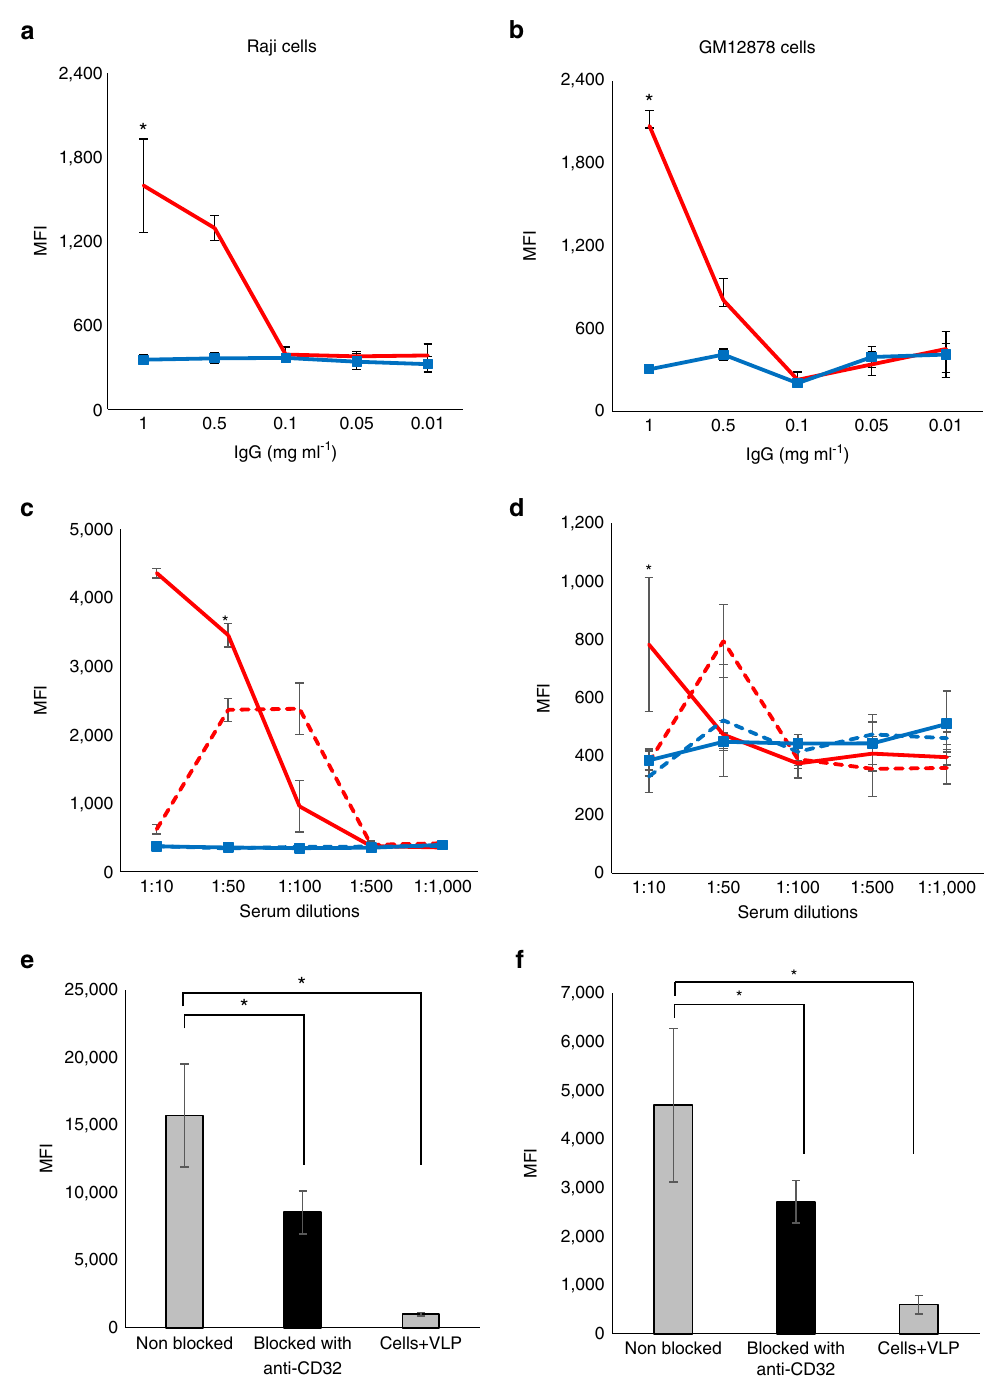
Figure 2 | Antibody-dependent uptake of VP2-VLPs in B cell lines. The mean fluorescence intensity (MFI) of VP2-VLP-AF647 was measured by flow cytometry in Raji (left column) and GM12878 cells (right column) after incubation with total purified B19V-positive (red line) or -negative IgGs (blue line, squares) ( a , b ). Pooled sera from B19V-IgG þ individuals either heat inactivated (red solid line) or non-heat inactivated (red dotted line) or pooled sera from B19V-IgG - individuals either heat inactivated (blue solid line, squares) or non-heat inactivated (blue dotted line) were used ( c , d ). * Represents statistical significance ( P o 0.001) between positive and respective negative controls at a given concentration. The effect on viral uptake was evaluated before (grey bars) and after (black bars) blocking with an anti-CD32 antibody ( e , f ). The difference was statistically significant (Raji P o 0.001, GM12878 P ¼ 0.05). Error bars represent s.d. (of four replicates). Statistical significance was calculated using Student’s t